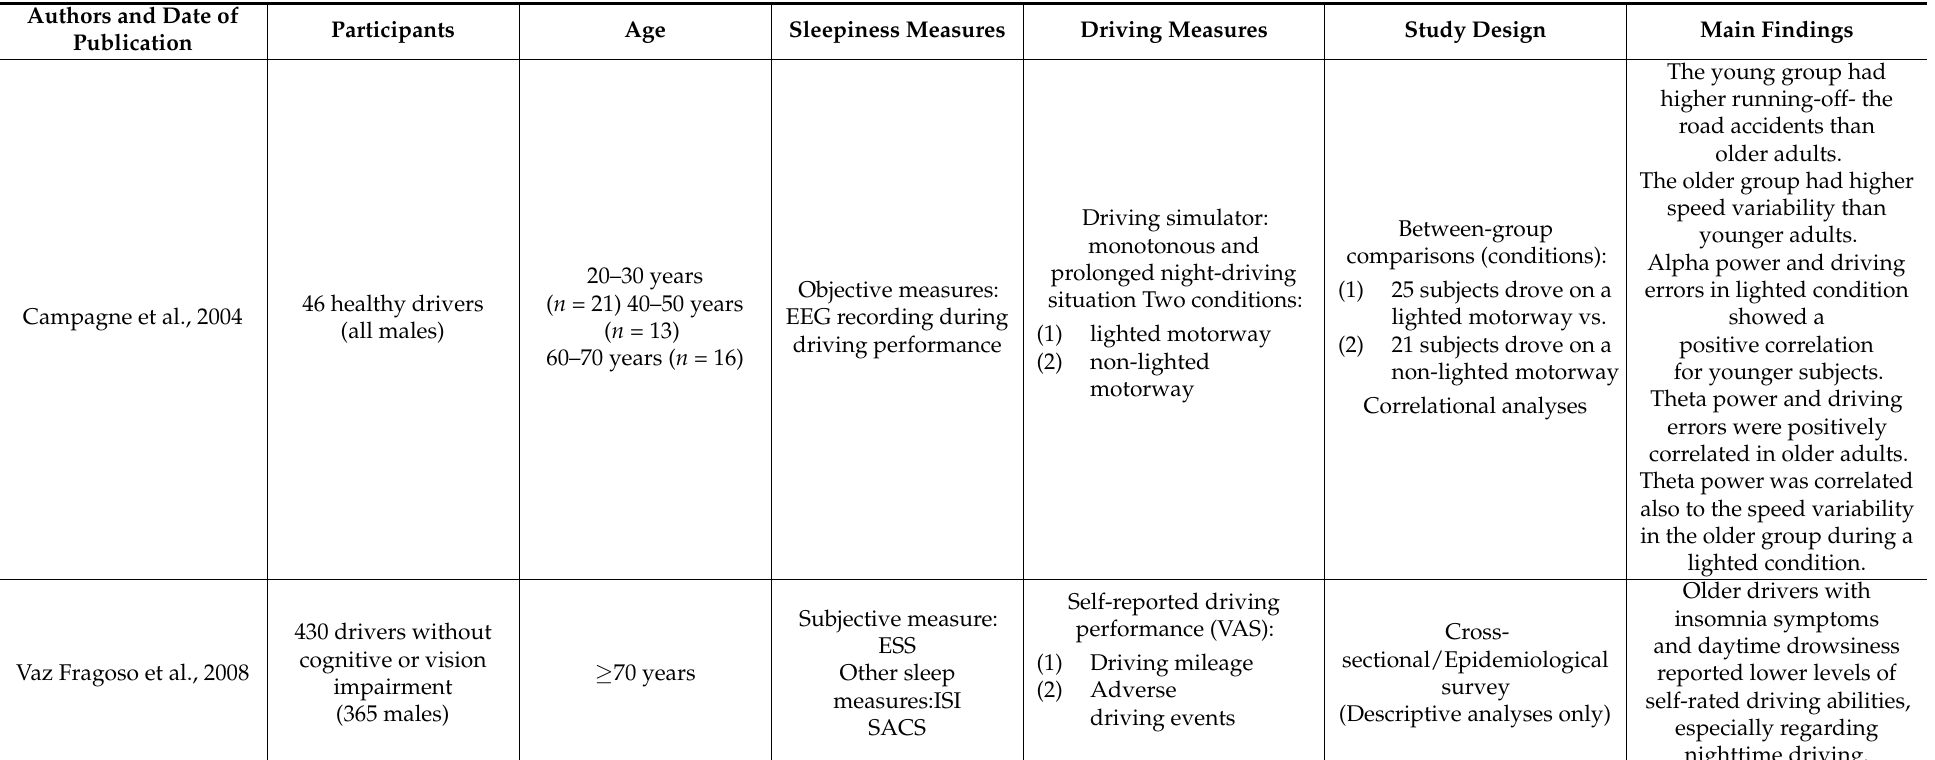
Table 1. Characteristics of the selected studies and main